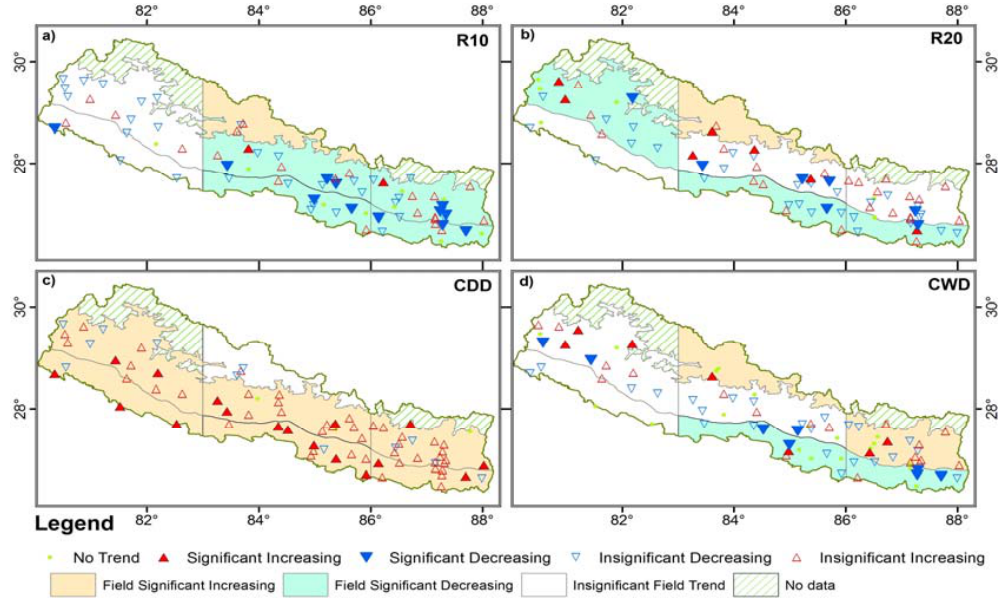
Figure 8. Stationwise and field significant trends for ( a ) R10; ( b ) R20; ( c ) CDD; and ( d ) CWD indices (significance at 0.1).